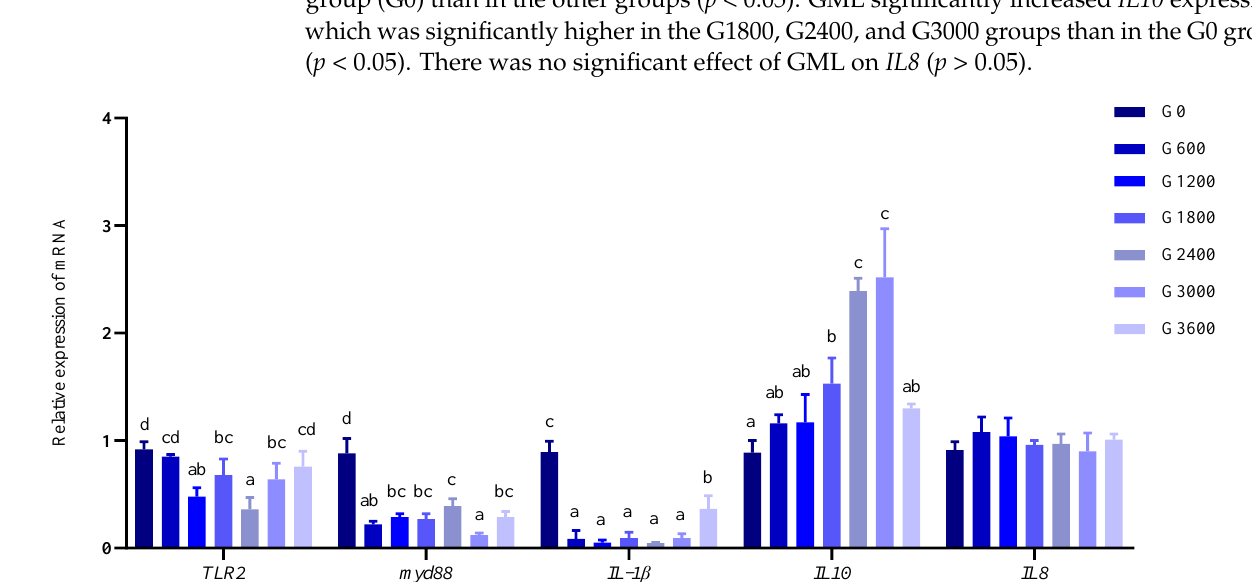
Figure 2. Effects of dietary GML levels on relative expressions of TLR2 , myd88 , TL-1 β , IL10 , and IL8 in head kidney inflammatory factors genes in bacterial challenge test for juvenile grouper. Data represent means of three tanks in each group; error bar indicates S.D. Values with different letters are significantly different ( p < 0.05). TLR2 : toll-like receptor 2; myd88 : myeloid differentiation primary response gene 88; IL-1 β : interleukin 1 β ; IL10 : interleukin 10; IL8 : interleukin 8.